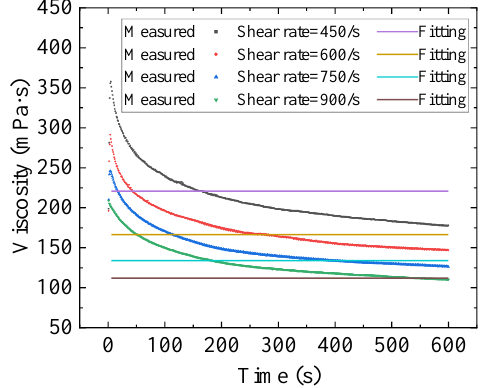
Figure A7. Toorman model transient viscosity fitting.